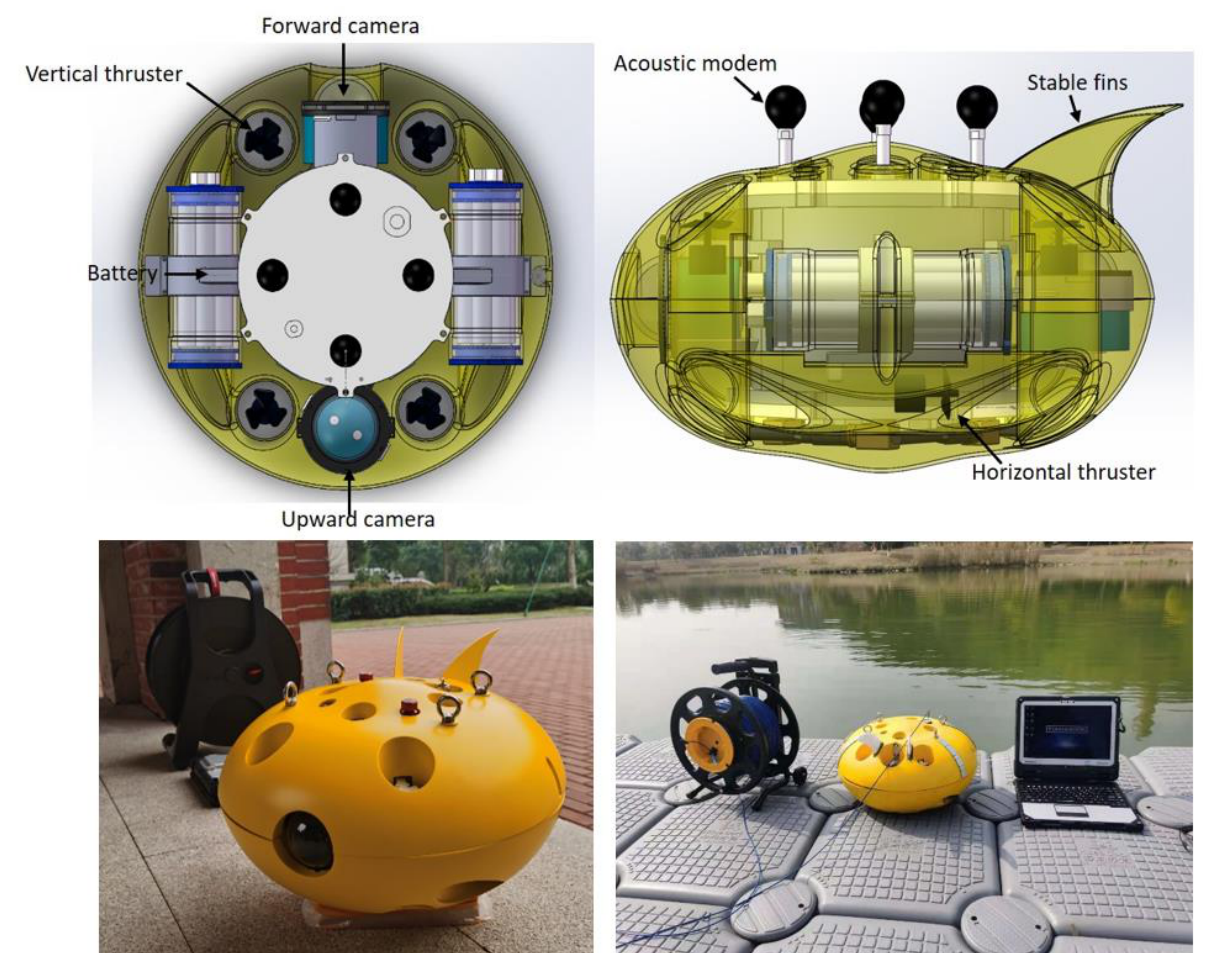
Figure 1. Autonomous underwater helicopter.